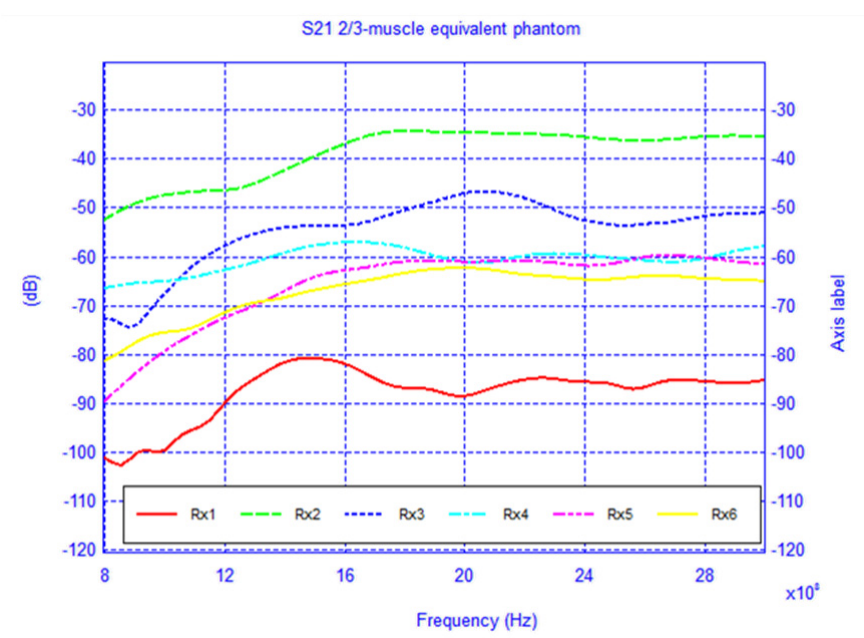
of the BAN network scenario with 2/3-muscle Figure 18. S 21